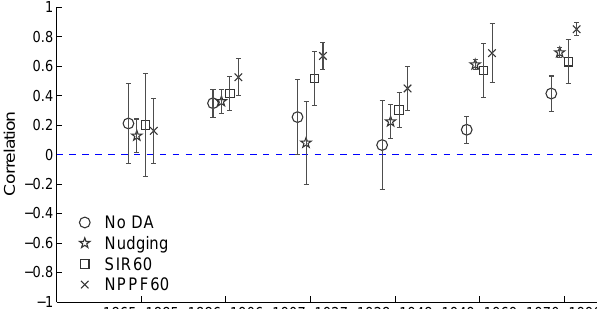
Fig. 8. Assimilation of sparse pseudo-observations. Correlations between first PCs of the pseudo-observations and projections of the model simulations onto the corresponding first EOFs of the pseudo-observations for surface air temperature for different time periods. EOFs are computed over the area southward of 60 ◦ S for May–October of 21-year periods from four runs. The circle is the mean correlation for simulations without data assimilation; the star is the mean correlation for the model simulations using the nudging; the square is the mean correlation for the model simulations using the sequential importance resampling filter over the polar cap southward of 60 ◦ S ; the cross is the mean correlation for the model simulations using the nudging proposal particle filter over the polar cap southward of 60 ◦ S . Error bars correspond to one standard deviation.